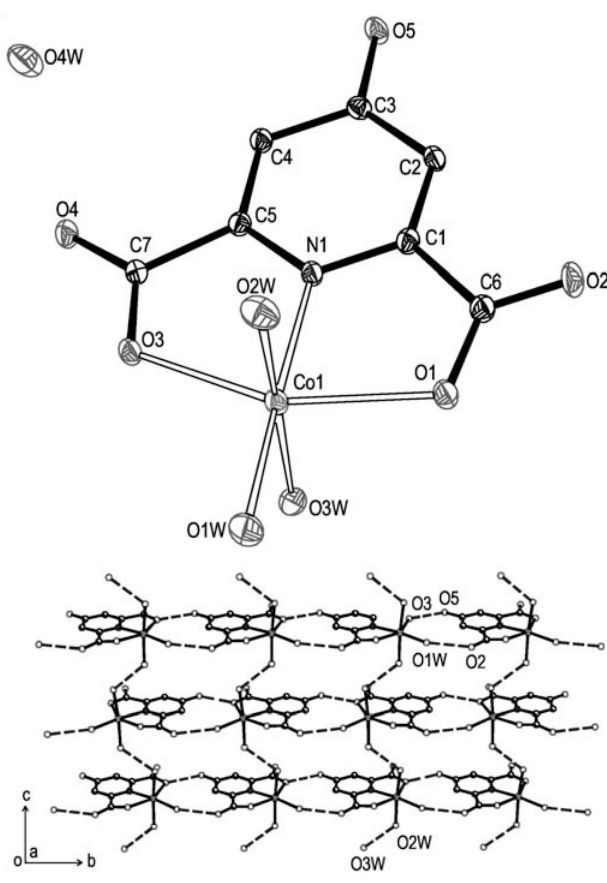
Table 1. Data collection and